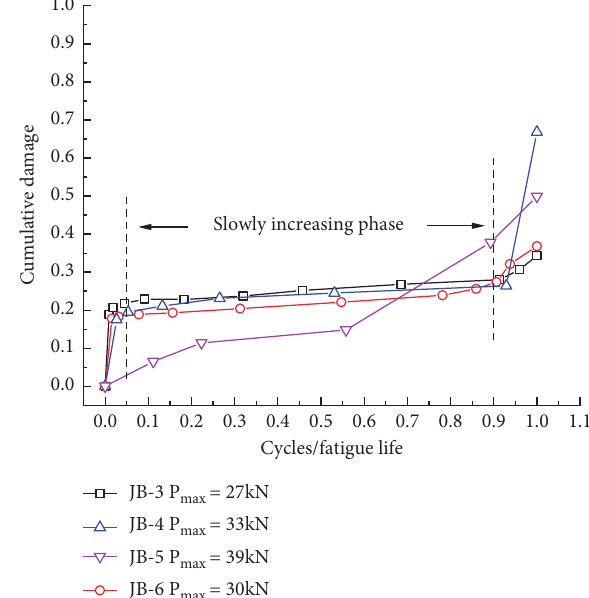
Figure 13: Cumulative damage curve of reinforced beam